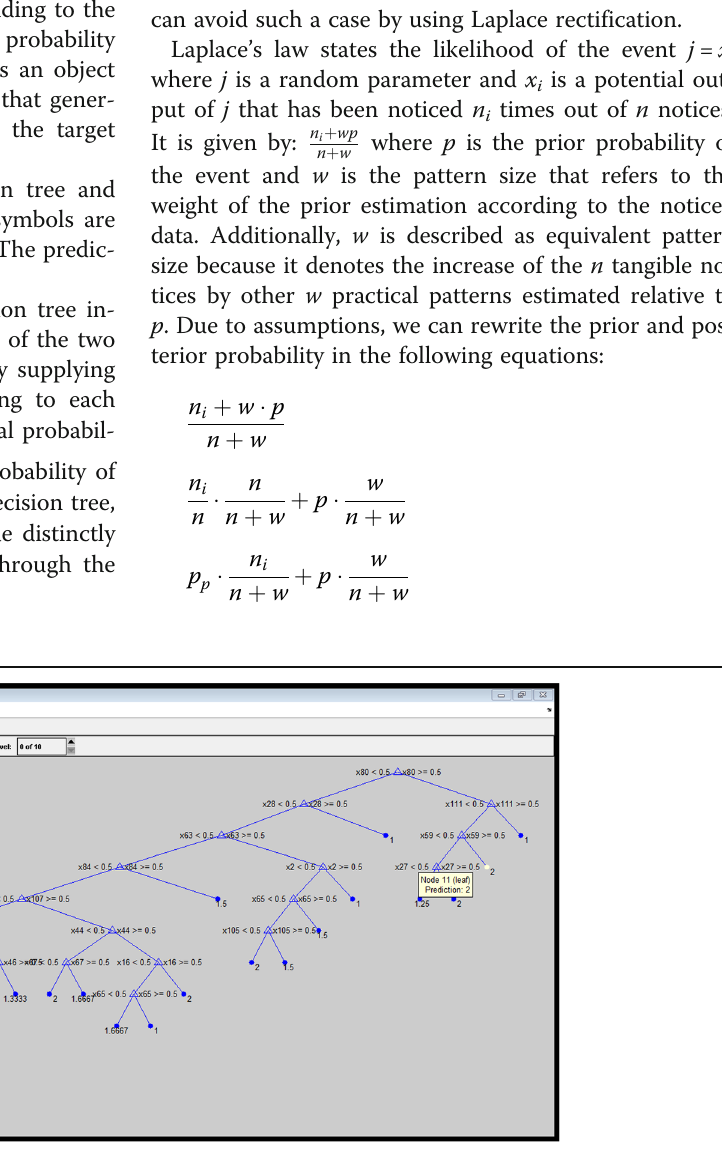
Fig. 3 Screenshot of the decision